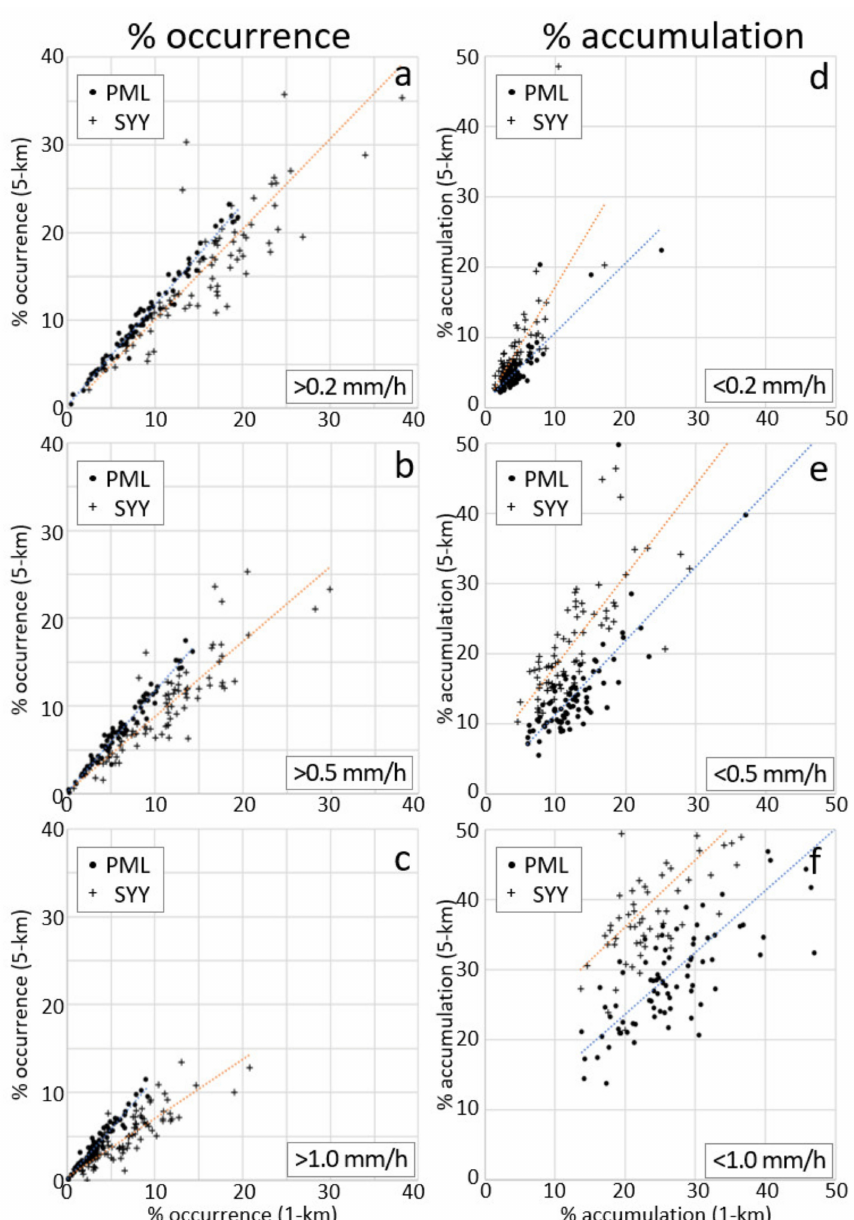
Figure 4. Comparison of the 1-km and 5-km surface radar resolution datasets showing the % occurrence of precipitation ( a – c ) above and proportion of the accumulation ( d – f ) below the thresholds set at 0.2, 0.5 and 1.0 mm/h. Dots represent the data for Plymouth (PML) and the crosses for Stornoway (SYY), while the dotted lines present the linear trend lines of each dataset. Each point represents the occurrence or accumulation calculated for each month from 2014 to